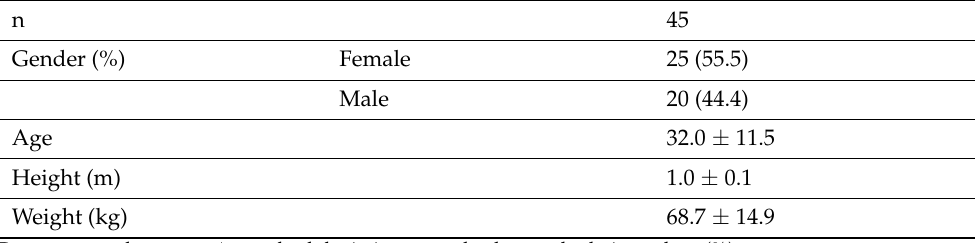
Table 1. Demographic characteristics of the participants.